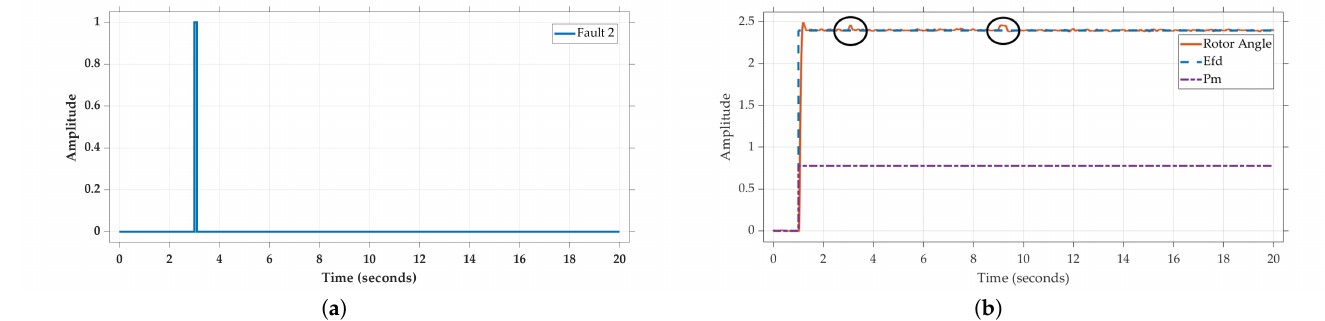
Figure 9. Synchronous generator subjected to Gaussian noise and fault at t = 3 s and t = 9 s, respectively. ( a ) t = 3 s fault characteristics; ( b ) rotor angle when E FD = 1, P m = 1, learning rate = 10, and